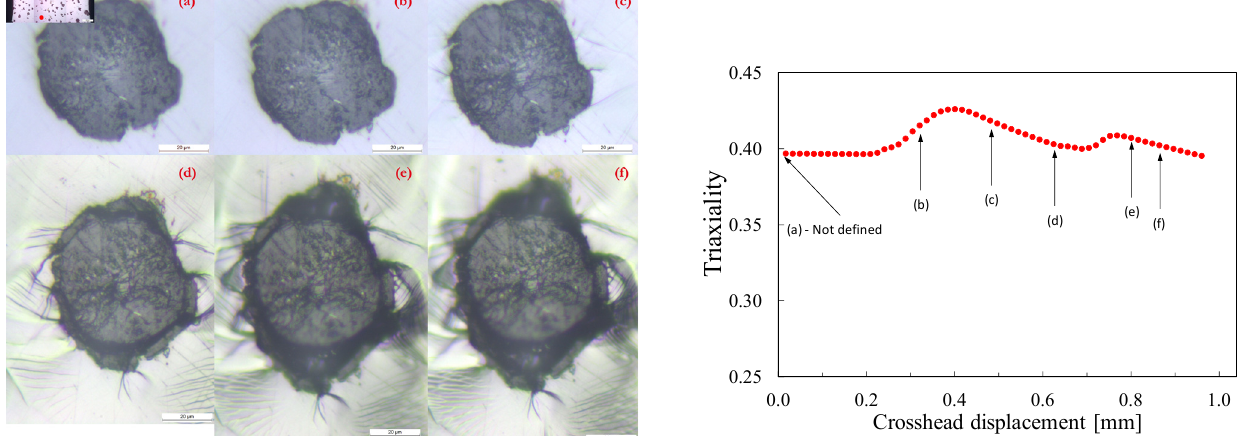
Figure 1: EN GJS350-22 ductile cast iron. Left: Digital Microscope in situ lateral surface analysis performed on notched specimen (red point indicates the investigated nodule). Right: Evolution of the Triaxiality Factor with the crosshead displacement [15].